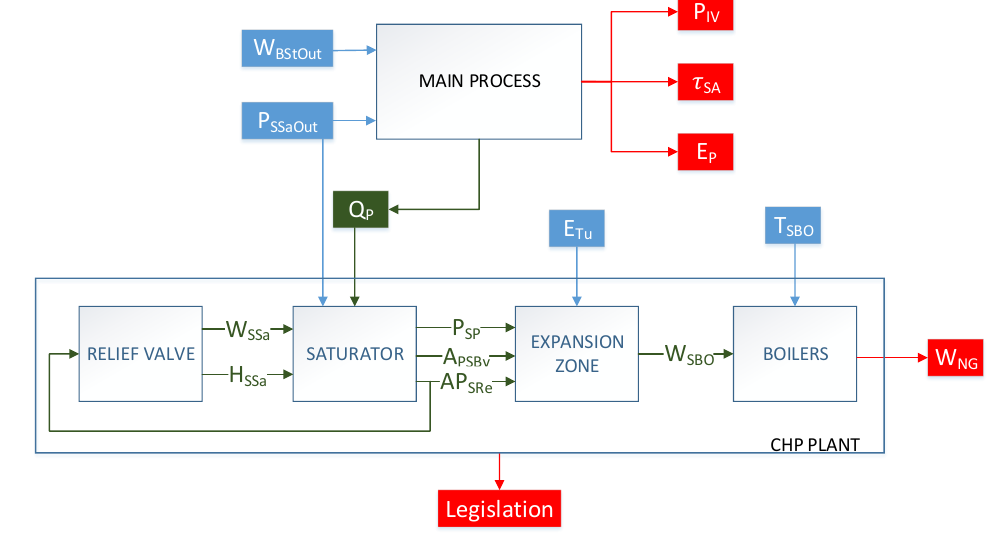
Figure 9. Dependency scheme of the